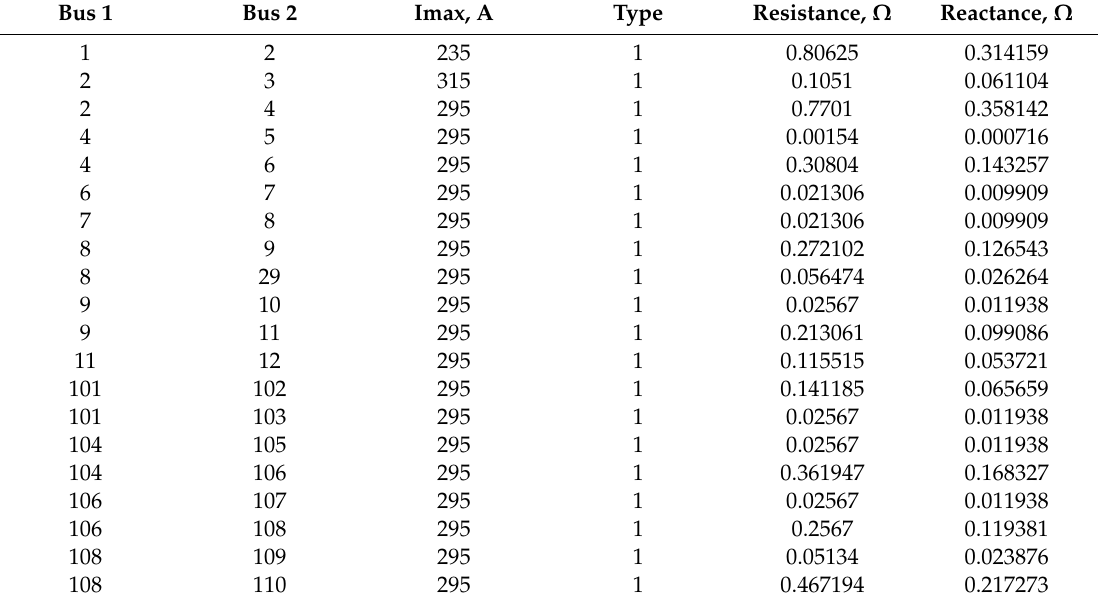
Table A2. Branch parameters for the 215-bus distribution